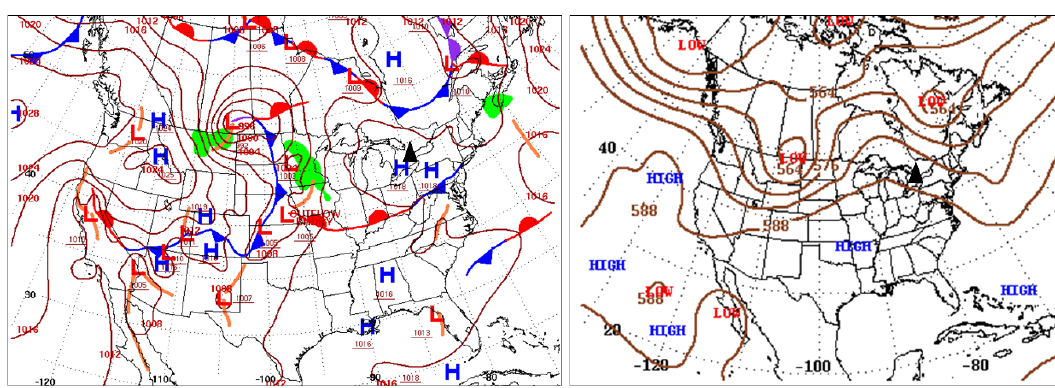
Figure 7. Panel ( a ) is the National Center for Environmental Prediction (NCEP) surface reanalysis map at 07:00 EST 28 July 2015. Panel ( b ) is the 500 hPa height contour, which can be used to indicate direction and strength of mid-troposphere winds. The solid triangle marks the study region.